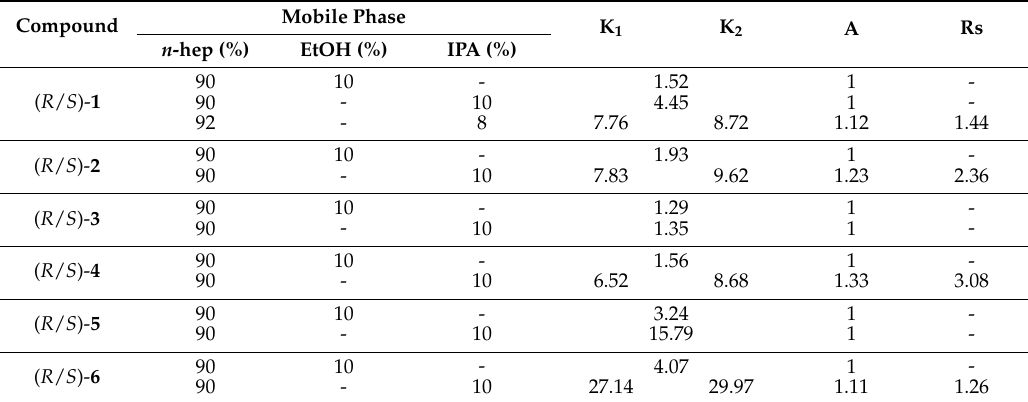
Table 3. Analytical screening on Chiralpak IC with different mobile phases containing 0.1% DEA and 0.3%